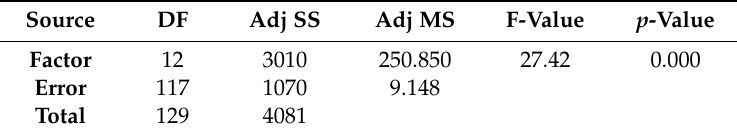
Table 1. Analysis of variance for flexural strength.